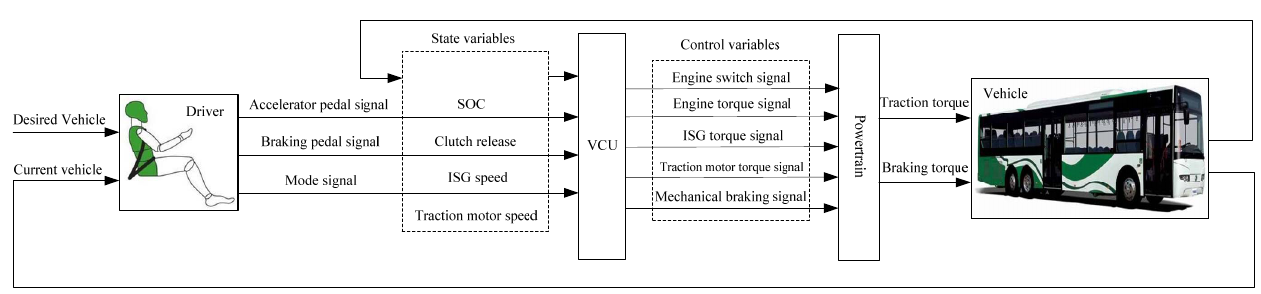
Figure 8. Schematic of the vehicle control